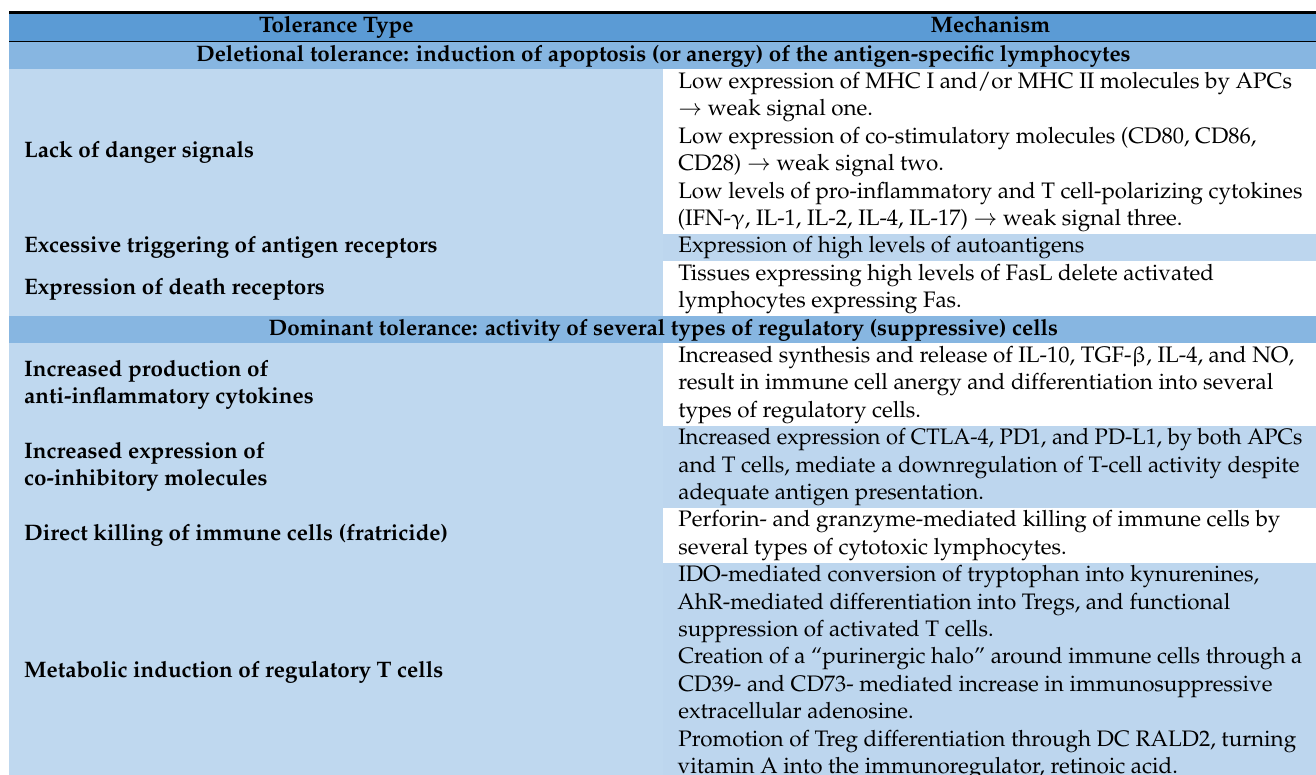
Table 1. Mechanisms of peripheral